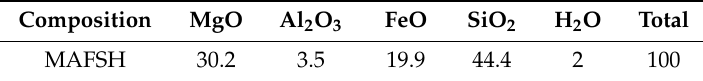
Table 1. Chemical composition (wt.%) of starting materials.